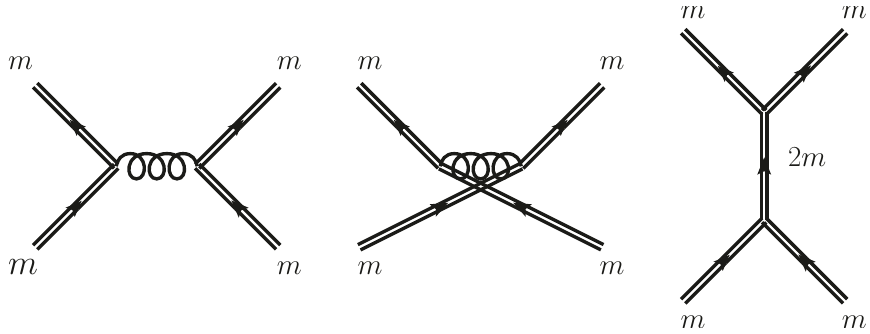
Figure 1 . Diagrams generically arising when a theory is taken on the Coulomb branch through assigning compact momenta. In some cases, the third diagram has vanishing color factor but is formally assigned a nonzero numerator factor. Mass (cid:13)ow follows the direction of the arrow and is conserved at each